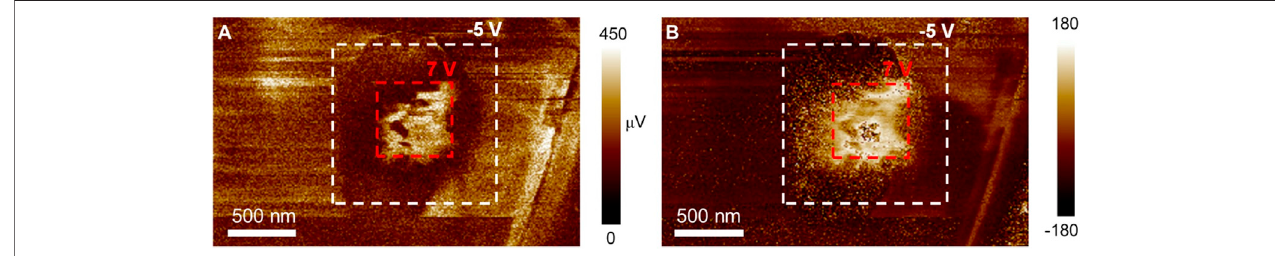
FIGURE 7 | The out-of-plane PFM amplitude (A) and phase (B) of as-grown α -In 2 Se 3 fl ake exfoliated on SiO 2 substrate. The red and white dashed areas are polarized using different driving voltages of +7 V and − 5 V, respectively. PFM, piezoresponse force